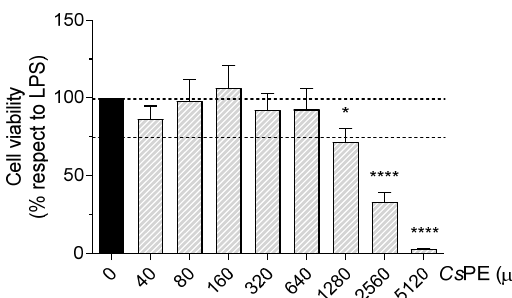
Figure 2. Cell viability analyzed by MTT assay on LPS-activated RAW 264.7 treated with Cs PE. RAW 264.7 cells were co-treated for 24 h with LPS 50 ng/mL and Cs PE at the indicated concentrations. The percentage of viable cells with respect to LPS-activated control was evaluated by MTT assay and reported as the mean ± SD of three independent experiments, each conducted in triplicate. Dotted lines indicate 100% and 75% of control viability. * p < 0.05, **** p < 0.0001, LPS/ Cs PE-treated (grey bars) vs. LPS-activated cells (black bar) (one-way ANOVA test).